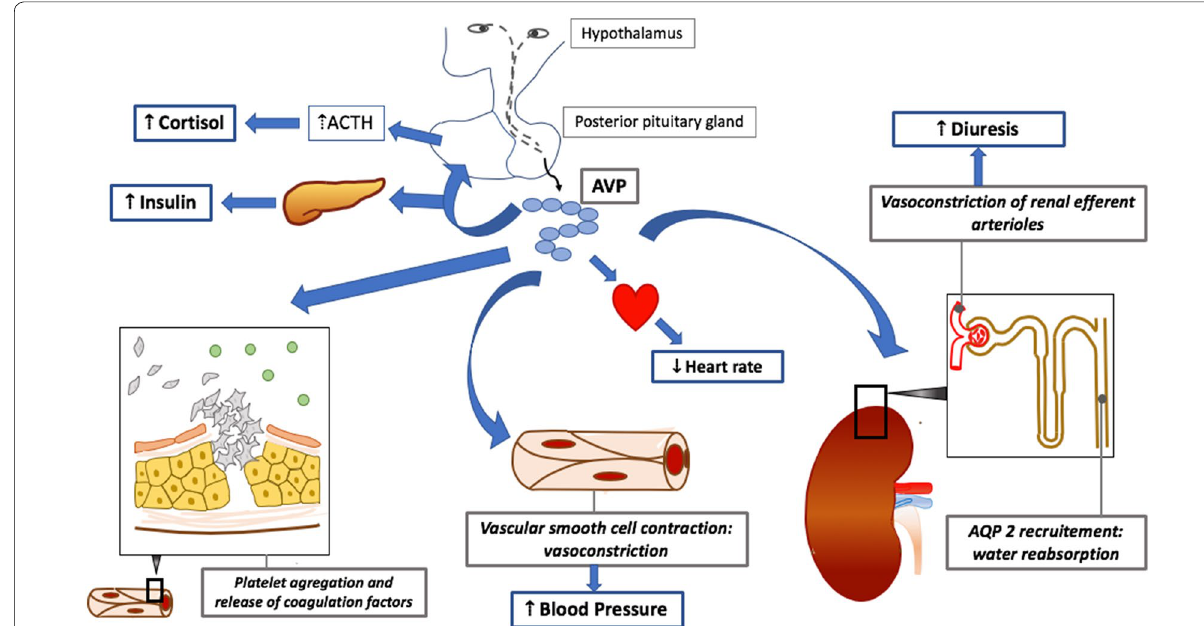
Fig. 1 Physiological effects of vasopressin. AVP Arginine VasoPressin, AQP2 Aquaporin 2. Vasopressin is synthesized in the hypothalamus and circulates along axons of magnocellular neurons to the post-pituitary gland. After stimulation, vasopressin is released into blood circulation, to 3 receptor subtypes. Binding on V1a receptors induces vascular smooth cell contraction in the periphery and on renal efferent arteriole and platelet aggregation. Vasopressin binding on renal V2 receptors causes aquaporin 2 recruitment, leading to water re-absorption and on extra-renal V2 receptors induces the release of coagulation factors. Binding on V1b receptors induces corticotropic axis stimulation and insulin secretion. During septic shock, vasopressin plasma level is low. Administration of vasopressin or its analogues induces a strong vasoconstriction, leading to an increase in blood pressure, and higher glomerular filtration